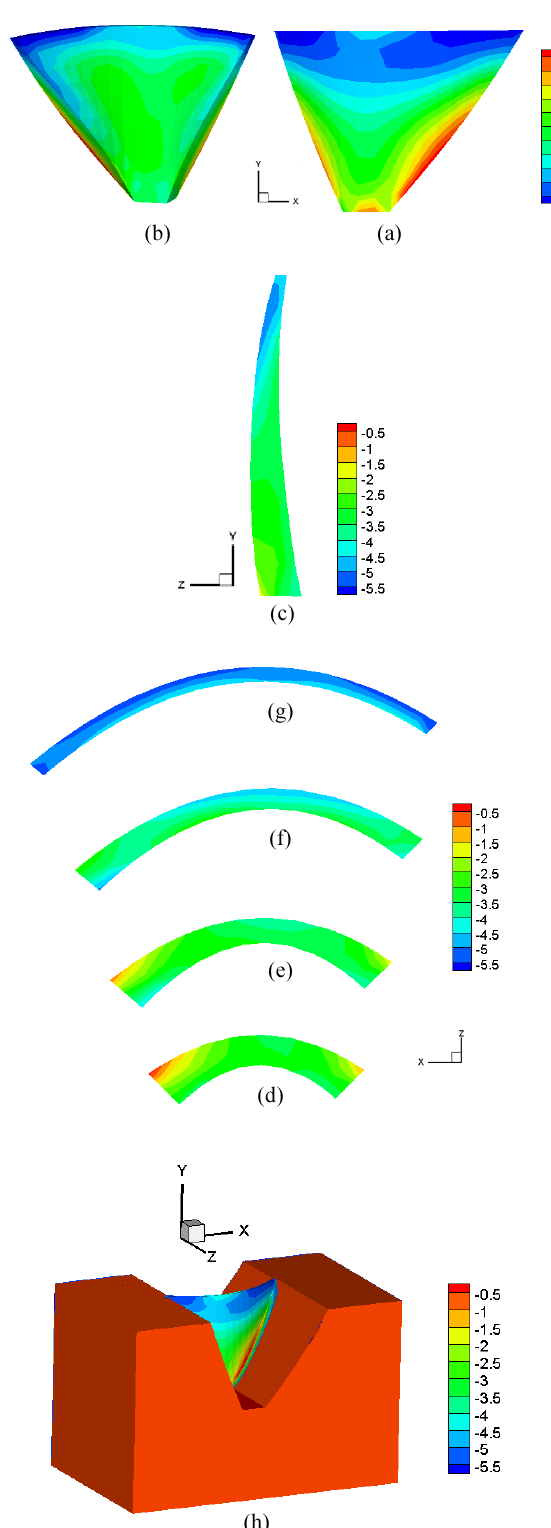
Fig. 9. principal stress distribution (σ 3 ) at the end of dam